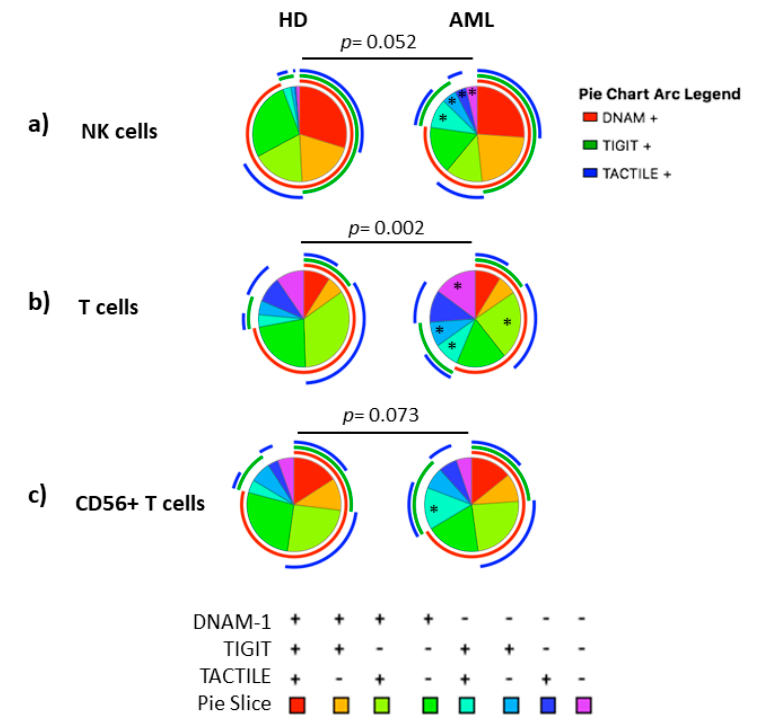
Figure 2. Co-expression patterns (pie charts) of DNAM-1, TIGIT and TACTILE analyzed in ( a ) NK cells, ( b ) conventional CD56 − T cells and ( c ) CD56 + NKT-like cells from healthy individuals ( n = 20) and AML patients ( n = 30). Positive and negative expression of DNAM-1, TIGIT and TACTILE were combined by Boolean gating to generate all possible subsets. Each color in the pie corresponds to specific combination of antigens indicated in the bottom part of the figure. The asterisk (*) within the slices refers to statistically significant di ff erences between AML patients and healthy donors for the indicated subsets ( p < 0.05). HD: healthy donors, AML: acute myeloid leukemia